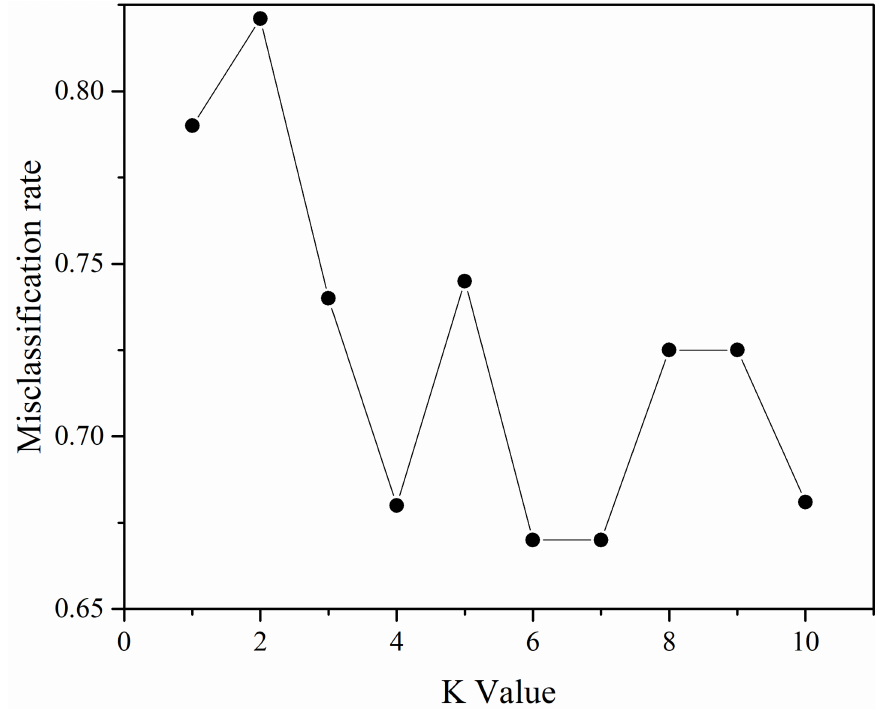
Figure 9. KNN model K-value selection.